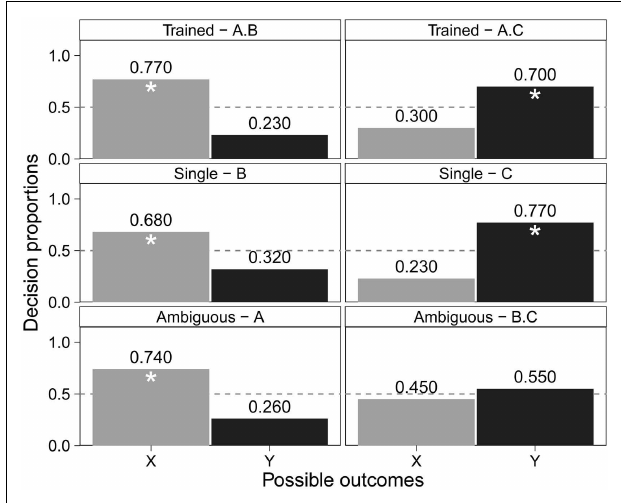
FIGURE 7 | Older children’s data from Burling andYoshida (2011): decision proportions for possible outcomes (X,Y) given predictive cues (A, B, C) with the asterisks identifying reliably above chance ( p < 0.05).